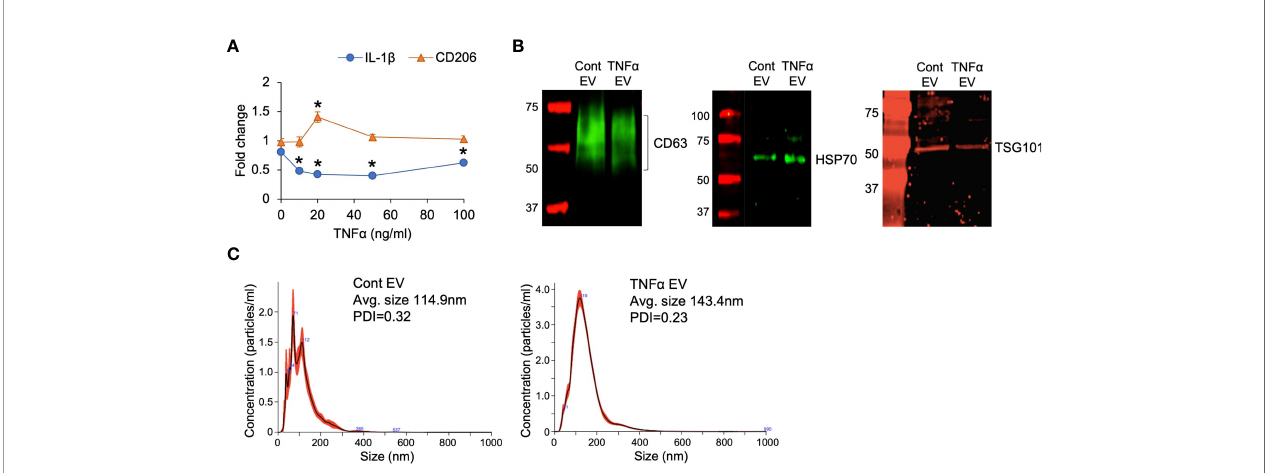
FIGURE 1 | EV characterization. (A) The effect of TNF a preconditioned MSC EVs on the expression of IL-1 b and CD206 in M1 polarized primary macrophages. Data is presented for two genes (IL-1 b and CD206) as representatives of M1 and M2 markers respectively. Fold change was calculated with respect to M1 macrophages in the absence of EVs. X-axis points refer to different concentrations of TNF a used for preconditioning. 20ng/ml was chosen as an ideal concentration for the subsequent experiments. *: statistical signi fi cance (P < 0.05) with respect to no EV control by Student ’ s t-test. (B) Expression of EV markers CD63, HSP70 and TSG101 in naïve (control) and TNF a EVs. (C) NTA plots of control and TNF a EVs showing their size